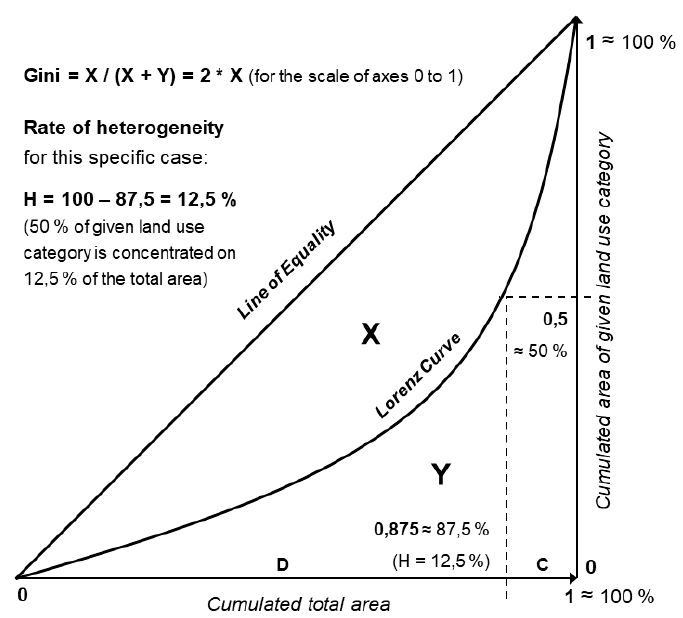
Figure 1. Lorenz curve, Gini coefficient (Gini), Rate of heterogeneity (H). Source: own scheme/work; see text for explanation.